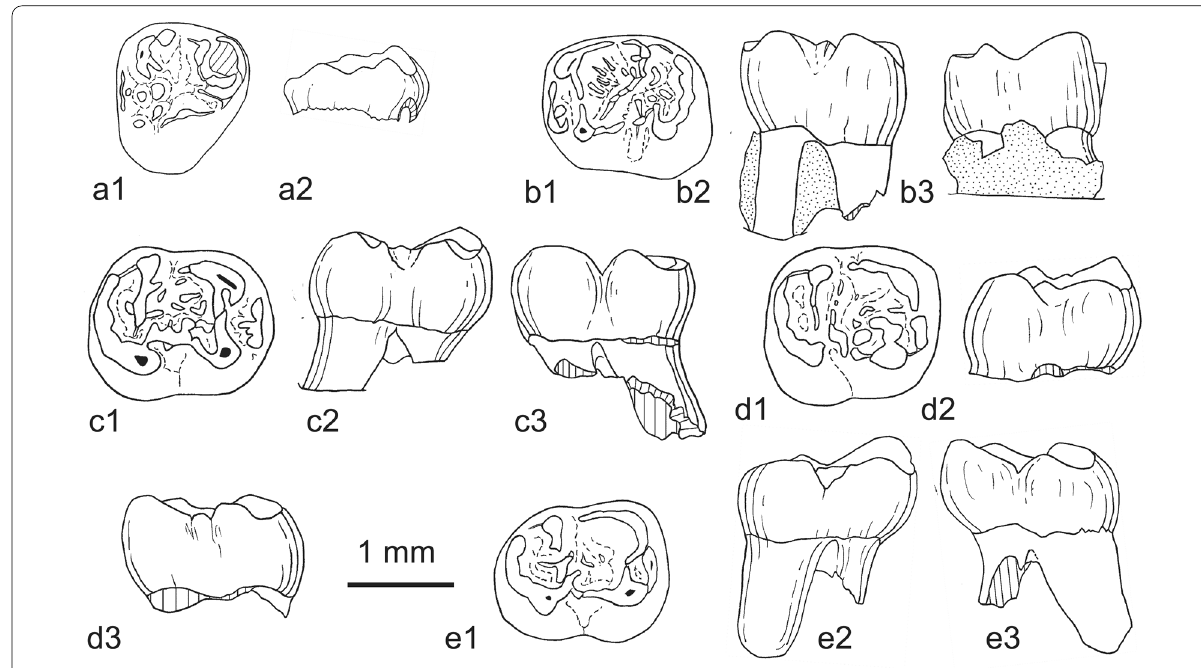
Fig. 49 Teeth of ? Protadelomys cf. maximini morphotype 1, from Saint‑Maximin (Gard). a SMX1‑261, right DP4; a1, occlusal view; a2, buccal aspect. b SMX1‑220, left m1; b1, occlusal view; b2, buccal aspect; b3, lingual aspect. c : SMX1‑224, right m1; c1, occlusal view; c2, buccal aspect; c3, lingual aspect. d SMX2‑210, right m2; d1, occlusal view; d2, buccal aspect; d3, lingual aspect. e SMX1‑401, right m3; e1, occlusal view; e2, buccal aspect; e3, lingual aspect. Scale bar 1 =